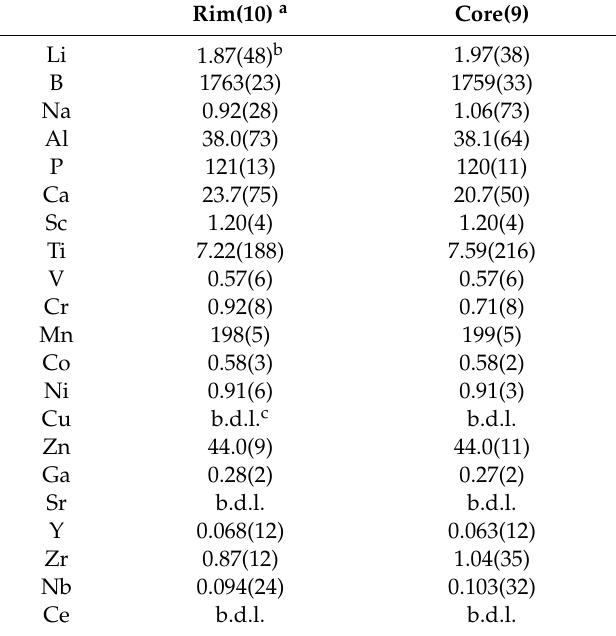
Table 2. Trace element compositions (wt ppm) of olivines in the jianite.